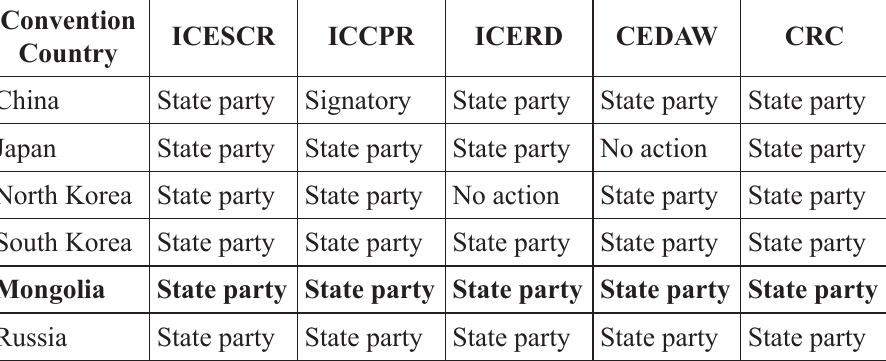
Table 5. Status of ratifications by Northeast Asian countries of